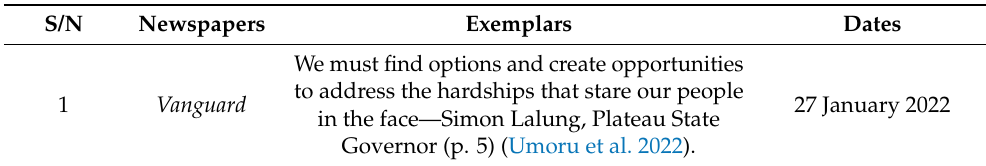
Table 1. Use of Suspicious